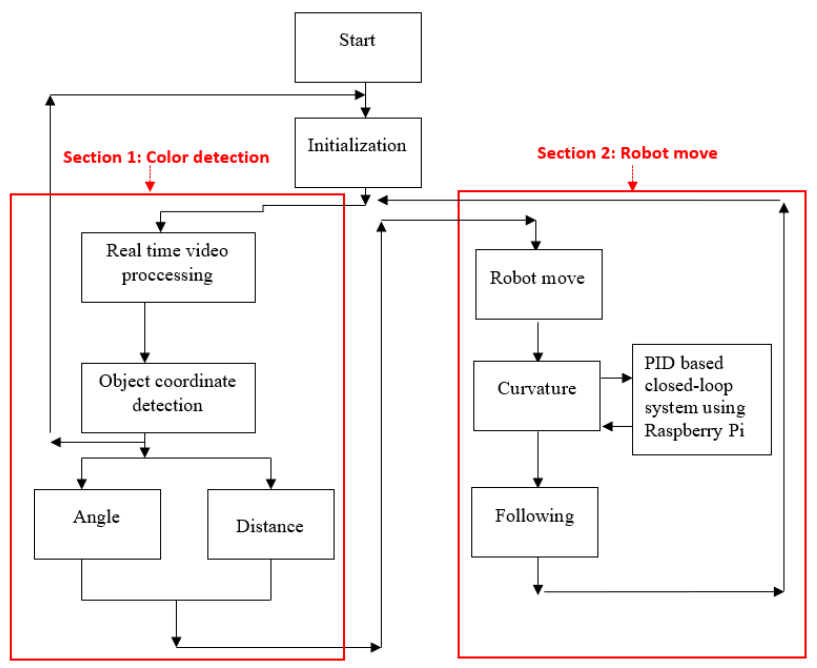
Figure 25. Flowchart of the overall system.